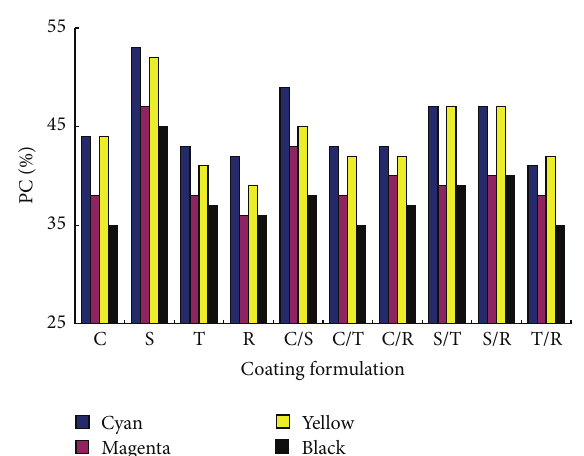
Figure 10: Effects of coating formulations on grayness values of color inkjet-printed papers. C: CaCO 3 ; S: SiO 2 ; T: talc; R: sericite, with mixing ratios of